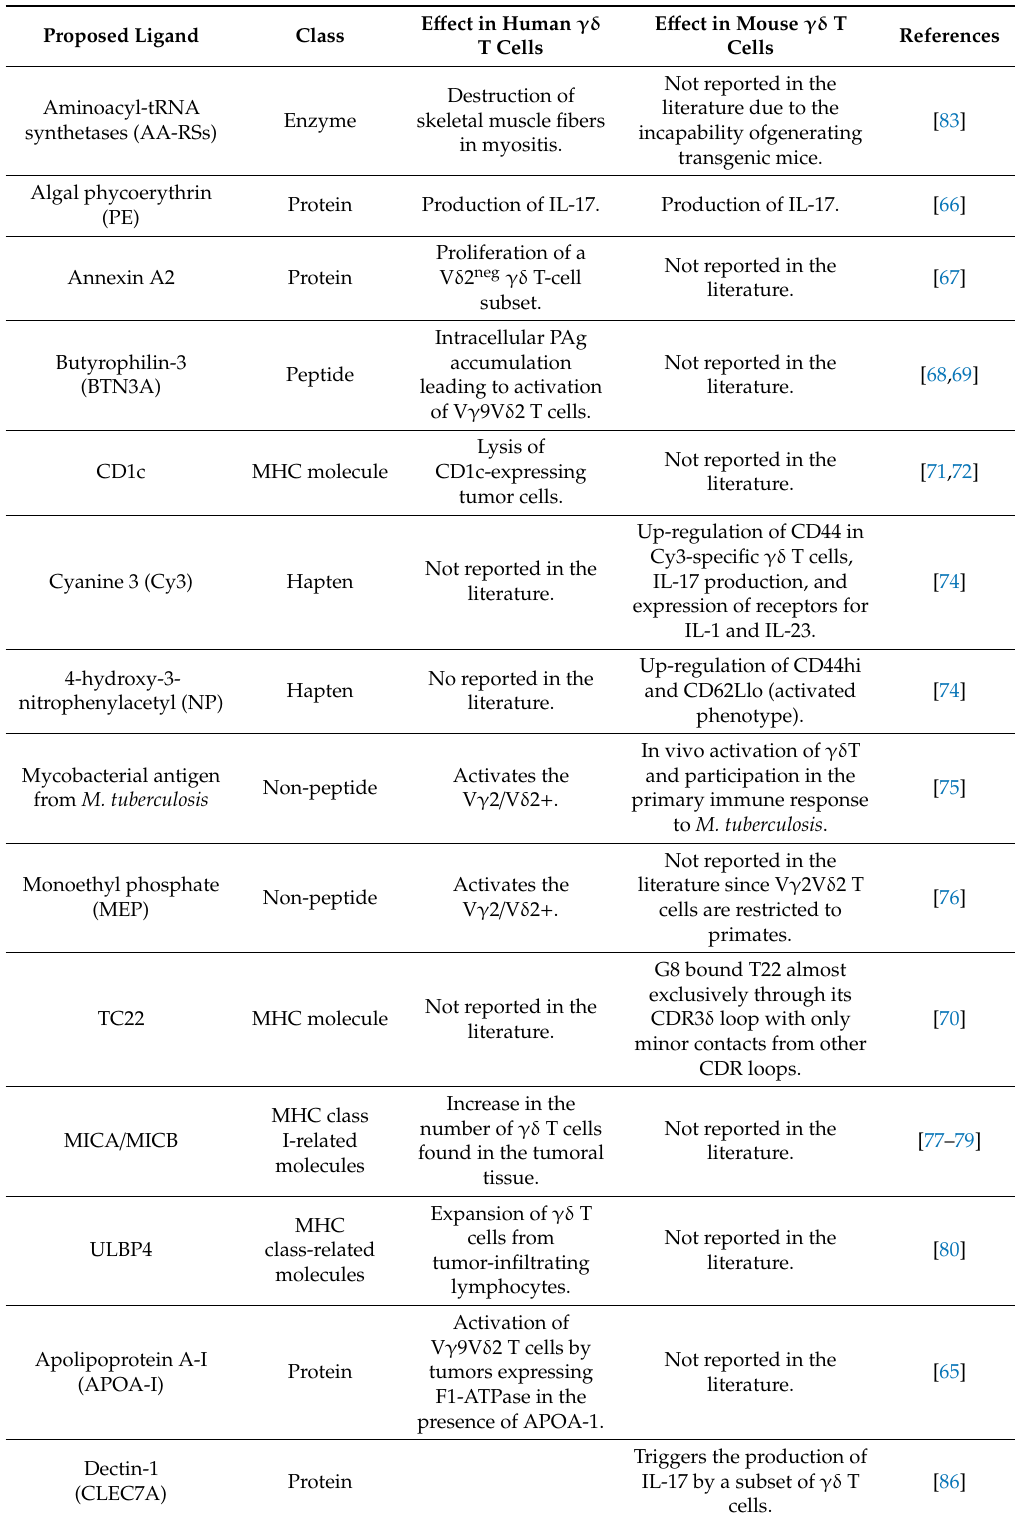
Table 1. γδ TCR ligands with biological e ff ects described in the literature. Classes of ligands and their e ff ects on humans and